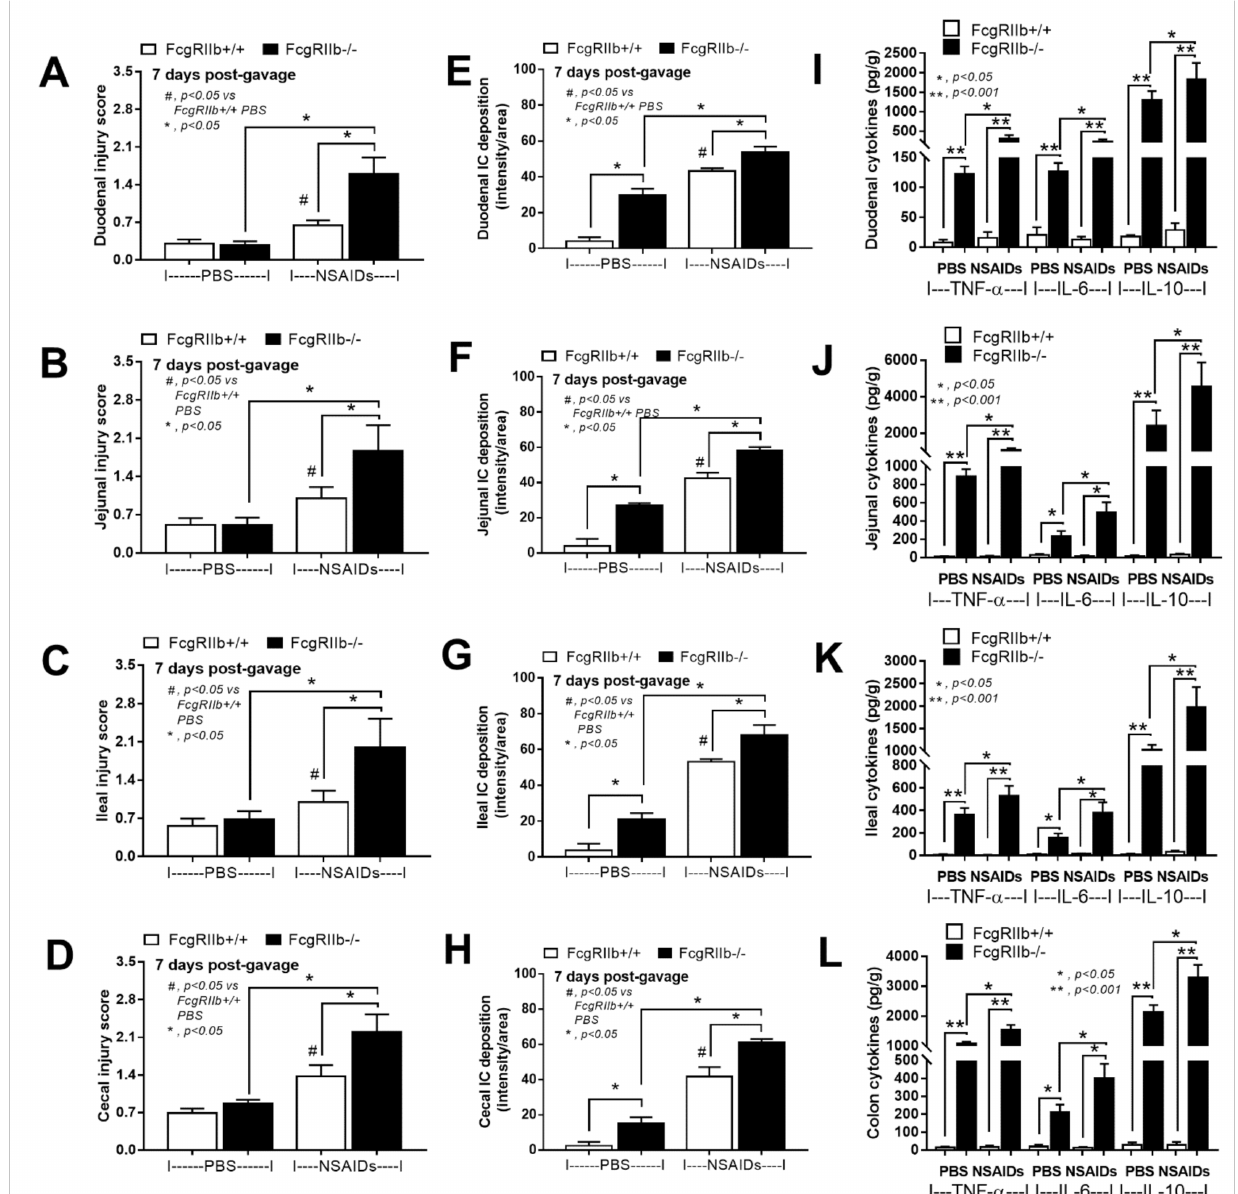
Figure 3. Characteristics of intestinal injury in FcgRIIb-/- lupus mice and wild-type (FcgRIIb+/+) mice after the administra- tion of indomethacin (NSAIDs) or phosphate buffer solution (PBS) control as determined by intestinal histopathological scores ( A – D ), immune deposition ( E–H ), and intestinal cytokines ( I–L ) ( n =